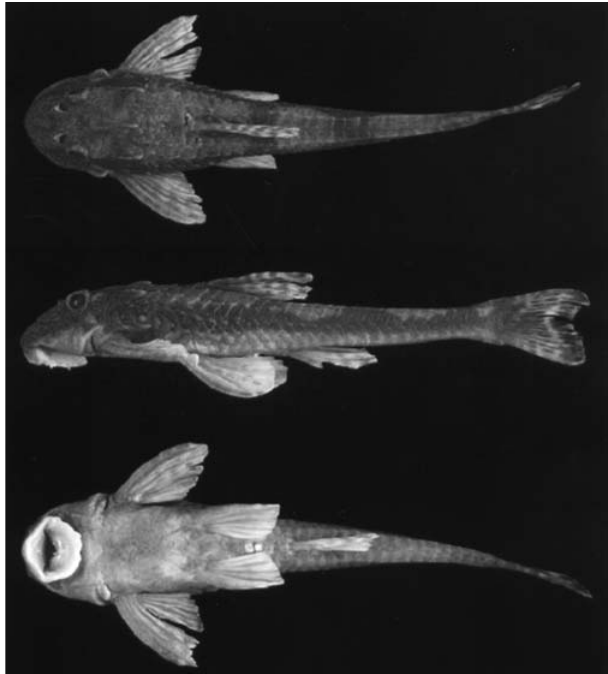
Fig. 4 . Pseudotocinclus juquiae , holotype, MZUSP 49333, 57.04 mm SL; first tributary of the rio Juquiá, near ribeirão das Antas on the road from São Lourenço da Serra to